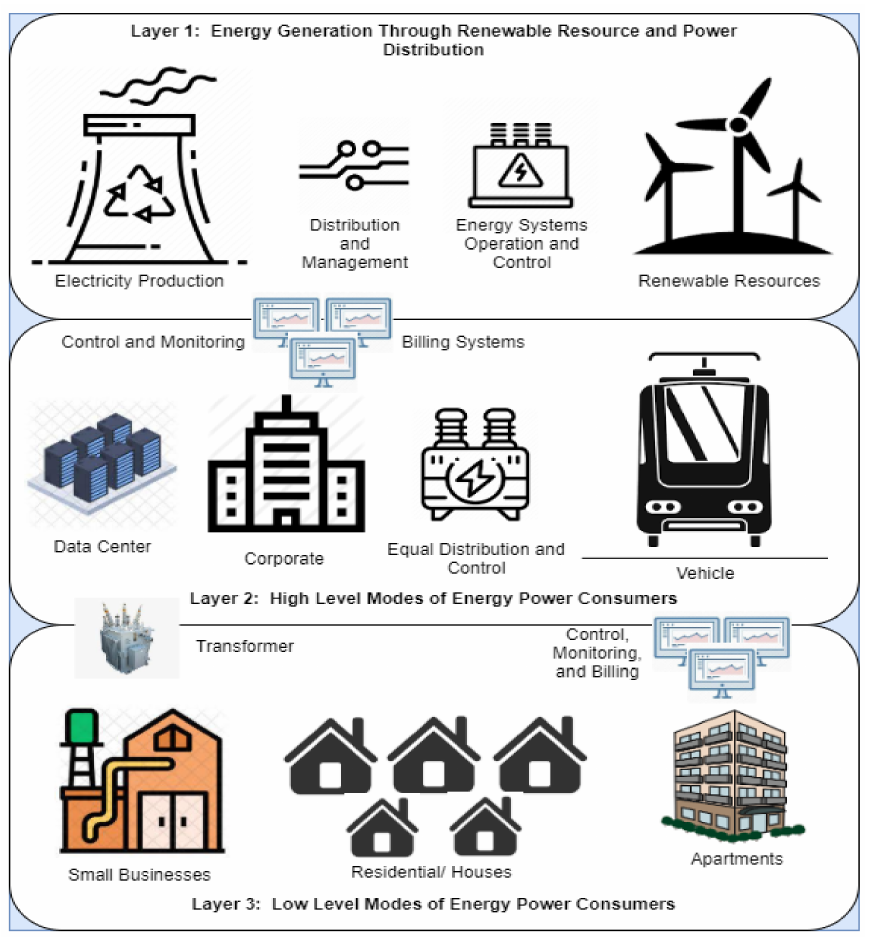
Figure 1. Traditional unsecure centralized energy power grid systems operation and control